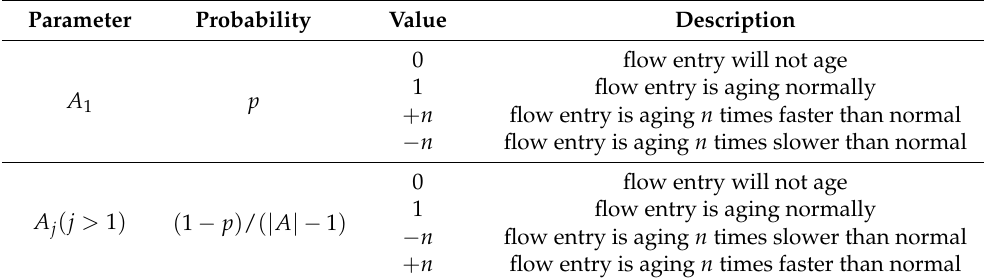
Table 3. Parameters and their descriptions: p is the probability of action A 1 , and n is a positive